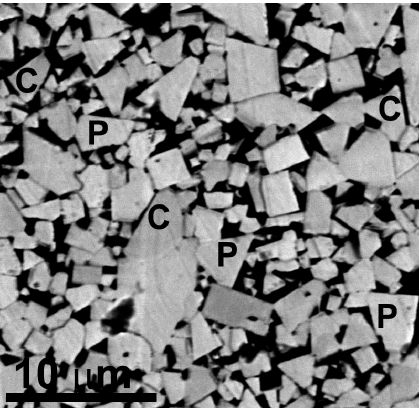
Figure 3. SEM micrograph of the ultra-coarse cemented carbide after liquid-phase sintering at 1380 °C. WC grains appear bright, and Co/binder appears dark. Letters indicate C: WC/WC grain boundaries completely wetted by the Co-based melt with zero contact angle; and P: WC/WC grain boundaries partially (incompletely) wetted by the melt with a non-zero contact angle. Reprinted with permission from Ref. [72]. Copyright 2017 Elsevier.